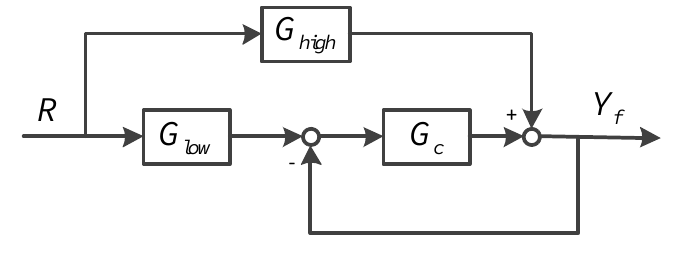
Figure 3. The CLF Figure 3. The CLF Scheme. Figure 3. The CLF Scheme. Figure 3. The CLF Scheme.